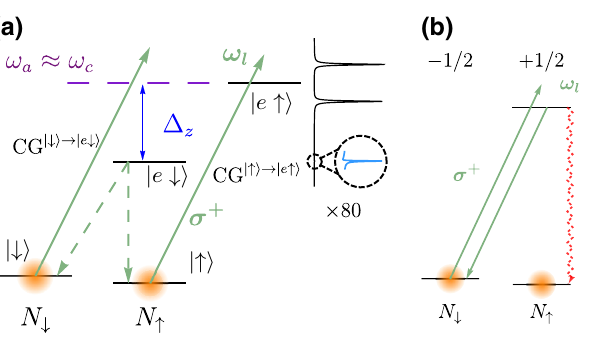
FIG. 7. (a) Energy level diagram for a four-level atom in a magnetic field. In this case we assume that the Zeeman splitting (cid:2) g . The Clebsch-Gordan (CG) coefficients (cid:15) κ , (cid:13) , and (cid:7) (cid:7) z z from |↓(cid:4) ↔ | e ↓(cid:4) and |↑(cid:4) ↔ | e ↑(cid:4) are different and individually labeled. The curve on the right in this subfigure is the cavity transmission spectrum, and the magnified blue line is the small transmission peak due to the |↓(cid:4) ↔ | e ↓(cid:4) transition. (b) Forward Rayleigh scattering |↓(cid:4) → |↓(cid:4) that is responsible for the collec- tive atom-light interaction (green lines) and spontaneous Raman scattering |↓(cid:4) → | e ↓(cid:4) → |↑(cid:4) (green and red lines) that causes additional spin noise.